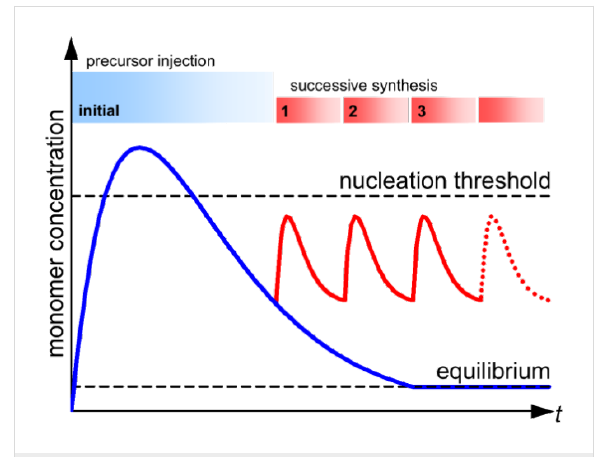
Figure 1: Schematic representation of the precursor concentration according to the LaMer model. The blue line represents the situation of a single injection; the particle size is limited by the precursor concen- tration. The red line shows the successive approach in order to increase the resulting particle size. During successive injection, the monomer concentration may not exceed the nucleation